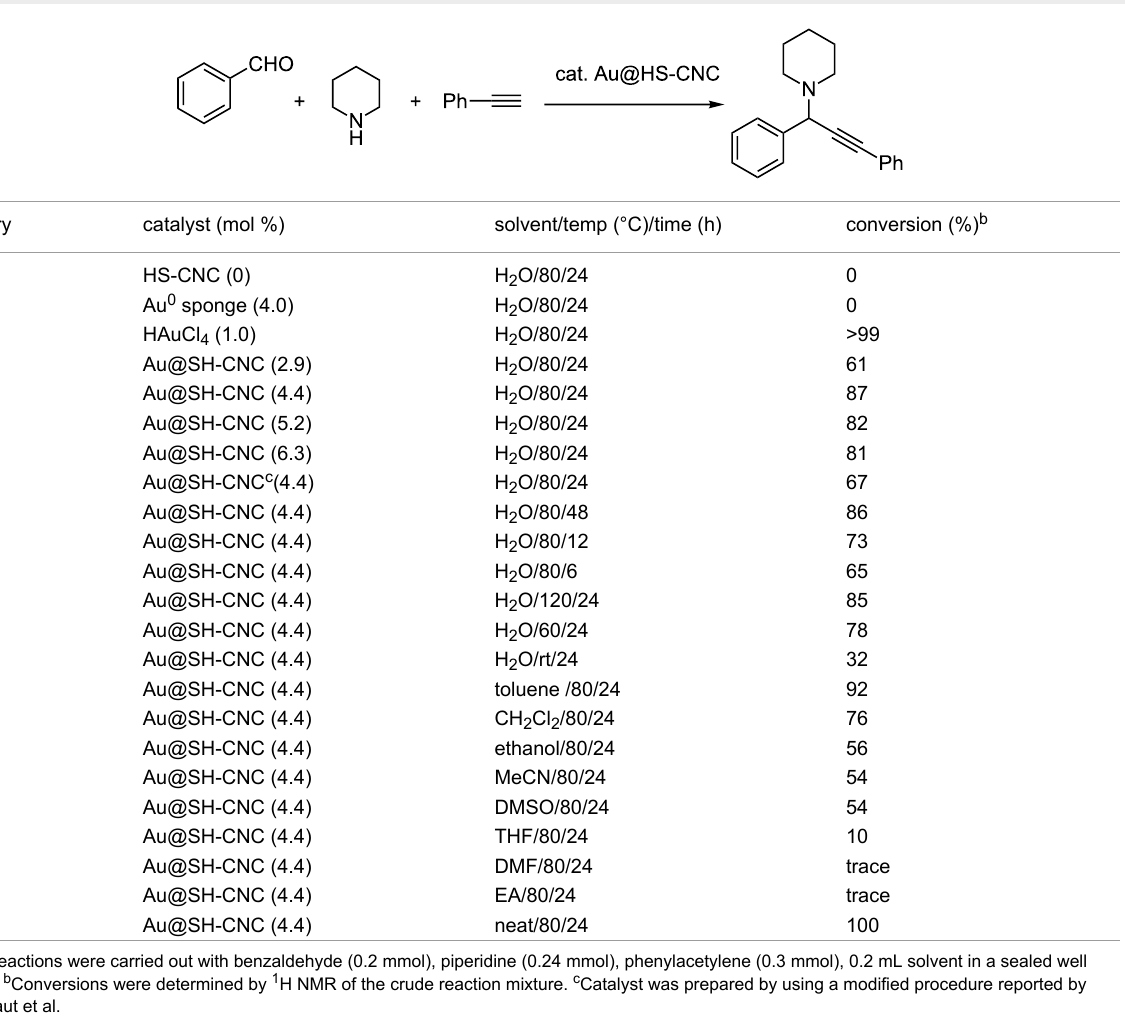
Table 1: Three-component coupling of benzaldehyde, piperidine, and phenylacetylene catalyzed by Au-based catalysts. a